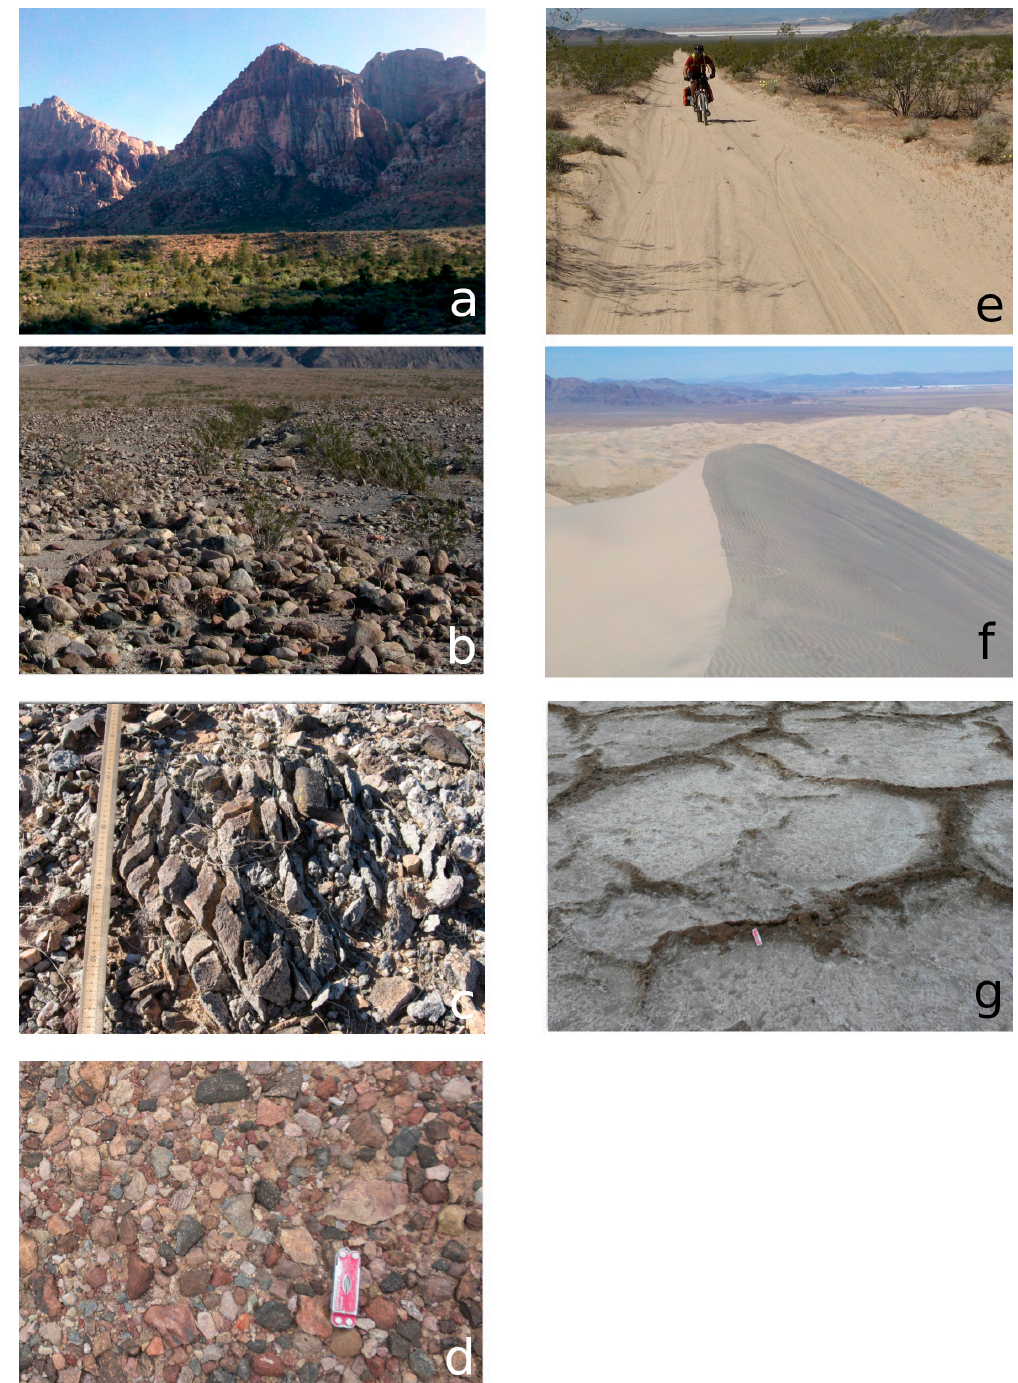
Figure 8. Surface type site examples from the Mojave region: ( a ) bedrock, sandstone cliffs at Red Rock Canyon National Conservation Area; ( b ) blocky, an alluvial fan in northern Death Valley; ( c ) coarse gravel, from near Amboy Crater; ( d ) fine gravel, a desert pavement surface near Tecopa, CA; ( e ) coarse sand, along the Mojave Road in the Mojave National Preserve; ( f ) fine sand, Kelso Dunes; ( g ) silt/clay, the wet playa at Badwater in Death Valley.